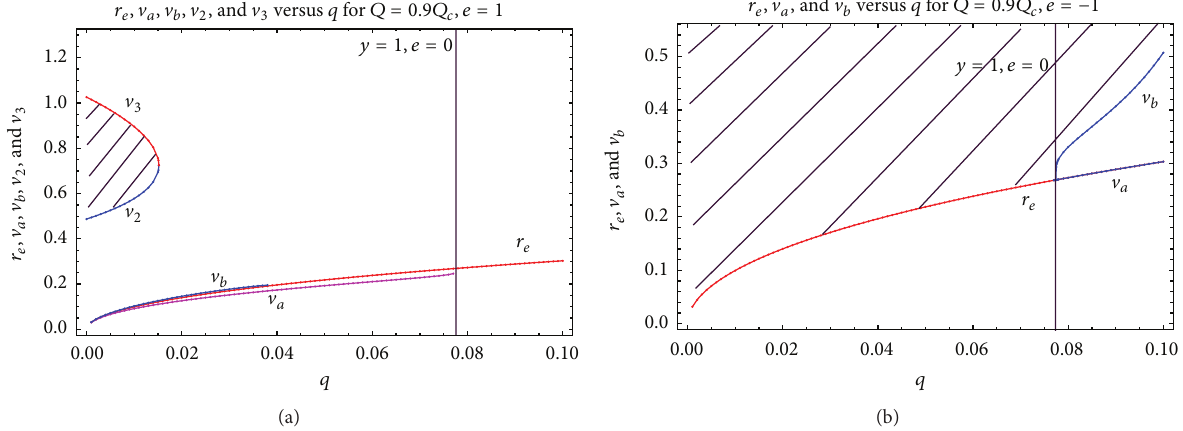
Figure 11: Allowed region of the mixed phase for AdS 5 from the charge constraint 𝑄 < 0.9𝑄 𝑐 for radiation with positive ( 𝑒 = 1 ) (a) and negative ( 𝑒 = −1 ) (b) charge, respectively. For all plots, we set 𝑔 𝑏 = 0 , 𝑔 𝑓 = 62/15 in order to compare with the zero-charge case with = 𝑔 = 2 . 𝑔 𝑏 𝑓